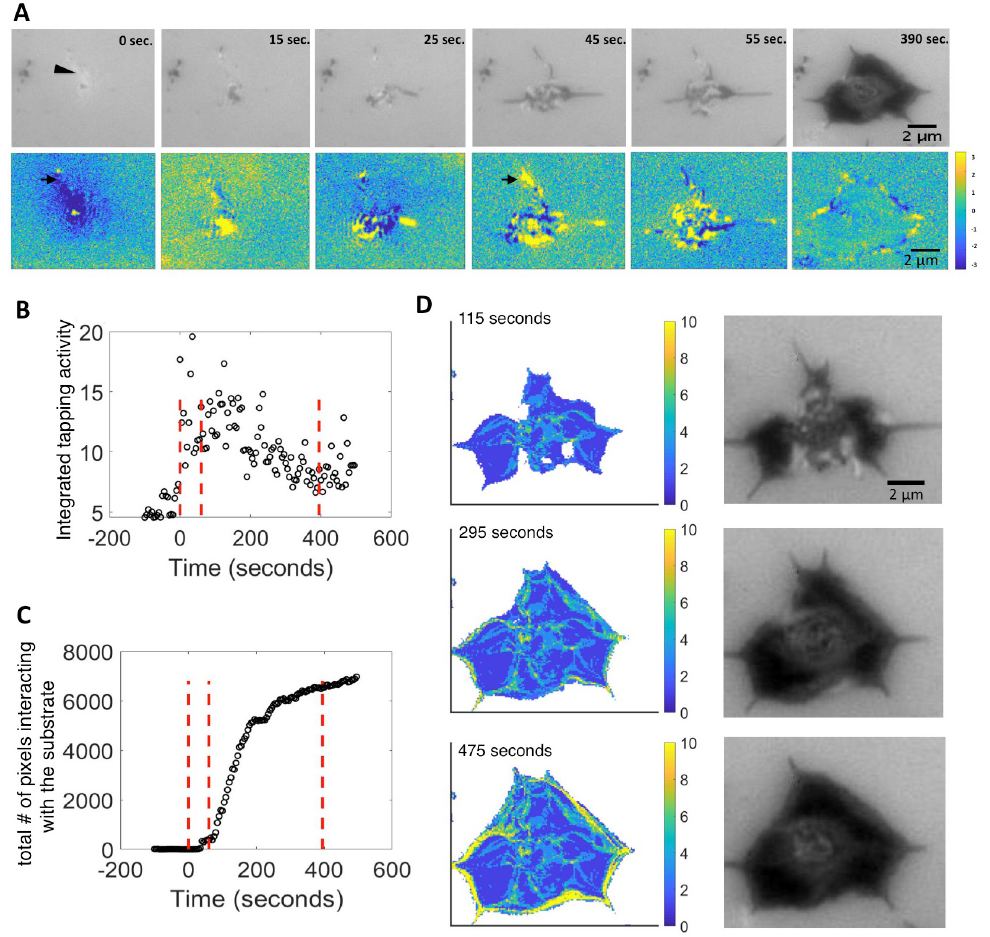
Figure 2. Quantification and image analysis of platelet spreading based on IRM live imaging for collagen IV. ( A ) Platelet spreading viewed by IRM, and the corresponding focal activity map, Δ IRM = IRM – IRM . Positive values (yellow) imply local attachment; t t t+1 negative values (blue) imply local detachment (bottom right). One filopodia initially attaching and detaching (black arrow). Scale bar 2 μm ( B ) Integrated tapping activity of platelets: the mean absolute value | Δ IRM| at every time point. X-axis: Time in seconds. Y-axis: Platelet mean activity. Red dotted lines separate the phases: background, prior to platelet attachment, filopodial spreading phase, lamellipodial spreading phase, and the fully spread phase. ( C ) Total number of pixels interacting with the surface over time. Time in seconds. ( D ) Accumulated attachment and detachment events over time shown by activity map, yellow/blue means more/fewer events. Accumulated attachment and detachment events are adjacent to the color map. Images on the right correspond IRM images. Scale bar 2